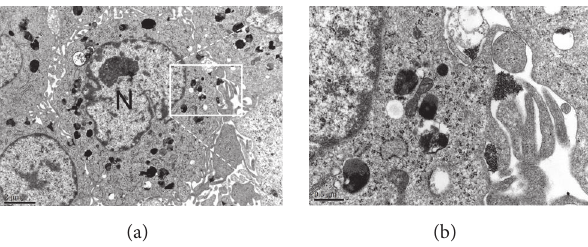
Figure 3: (a) and (b) TEM images of MIRB internalized in hDPSCs; (b) rRepresents several vesicles loaded with MIRB selected from the boxed area of (a). The magnification of image (b) is 40000 x. The bar in image (a) is 2 𝜇 m; in (b) it represents 500